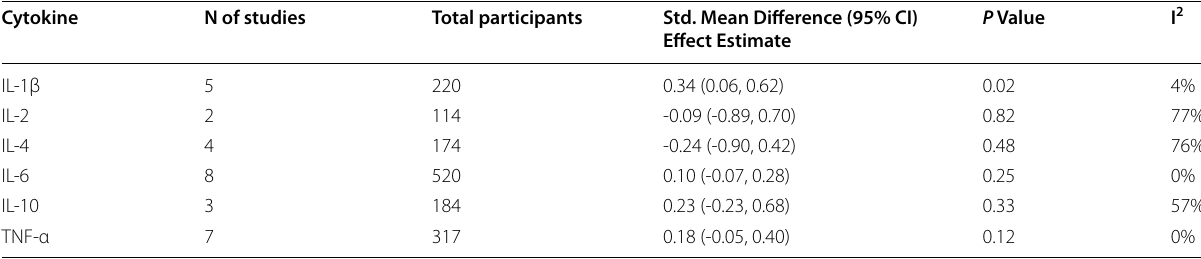
Table 3 Differences in circulating cytokines levels in the ictal stage of migraine compared to the inter-ictal